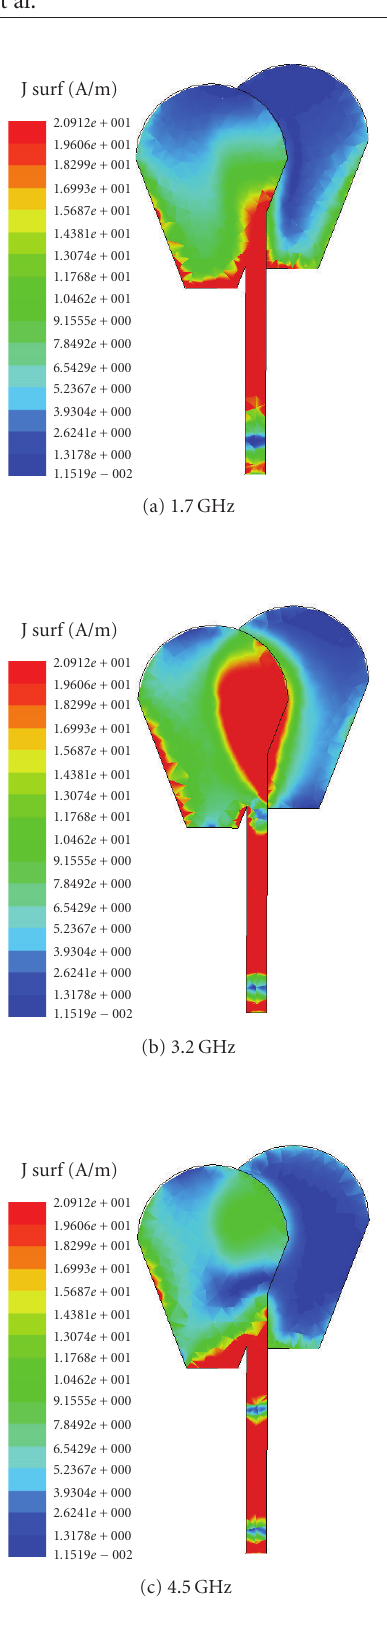
Figure 7: Simulated current distributions of the proposed antenna at (a) 1.7GHz, (b) 3.2 GHz, (c) 4.5 GHz [ L = 67, W G = 67, L G = 29, W W . 5, L R S . 3, L M = 15, M = 3, R = 7 R = 19, R = 11, H 1 = 0 . 5, S S . 25, h = 1 . 6 (units in mm), ε . 4]. S L 1 = 6 H 2 = 3, L 2 = 5 r = 4